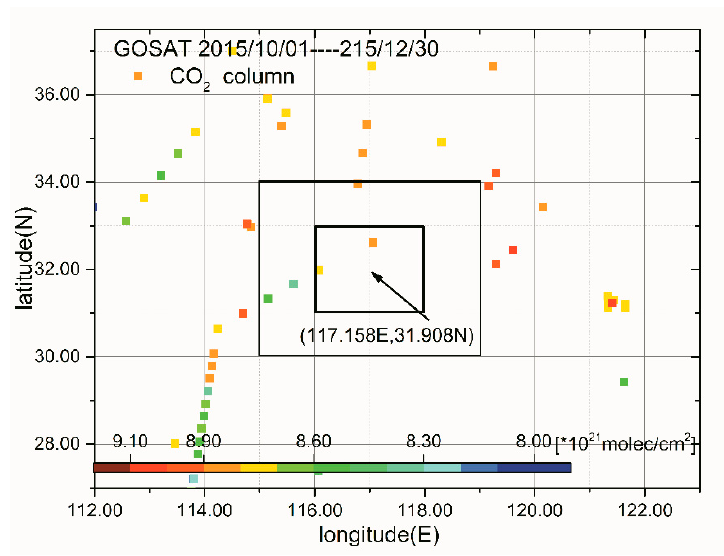
Figure 11. GOSAT CO2 total column from October to December, 2016, for a specific ground pixel ((117.158 ± 5) °E, (31.908 ± 5) °N).